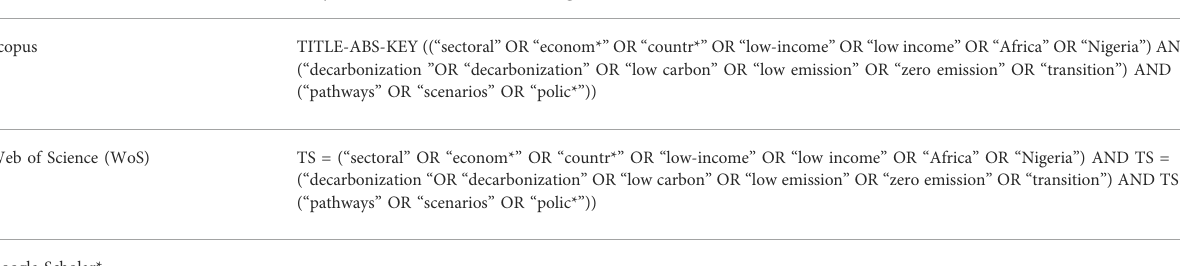
TABLE 2 The search strings used for database